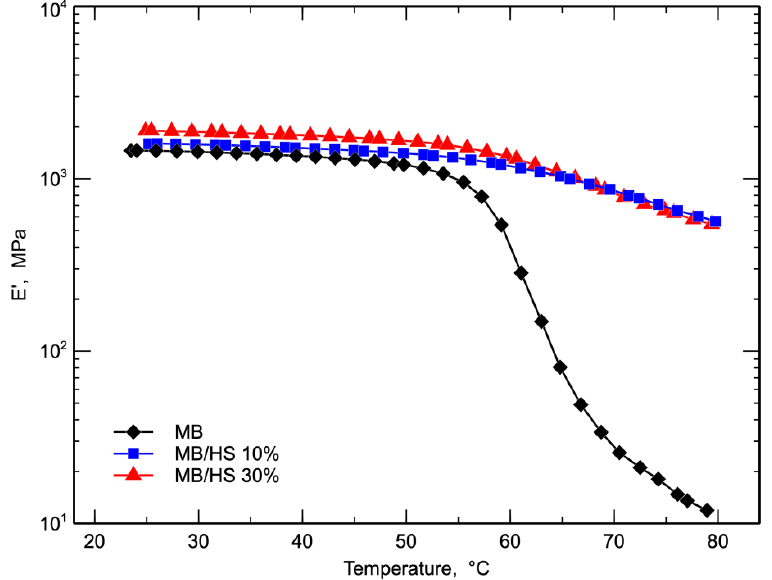
(cid:48) ) curves of MB and